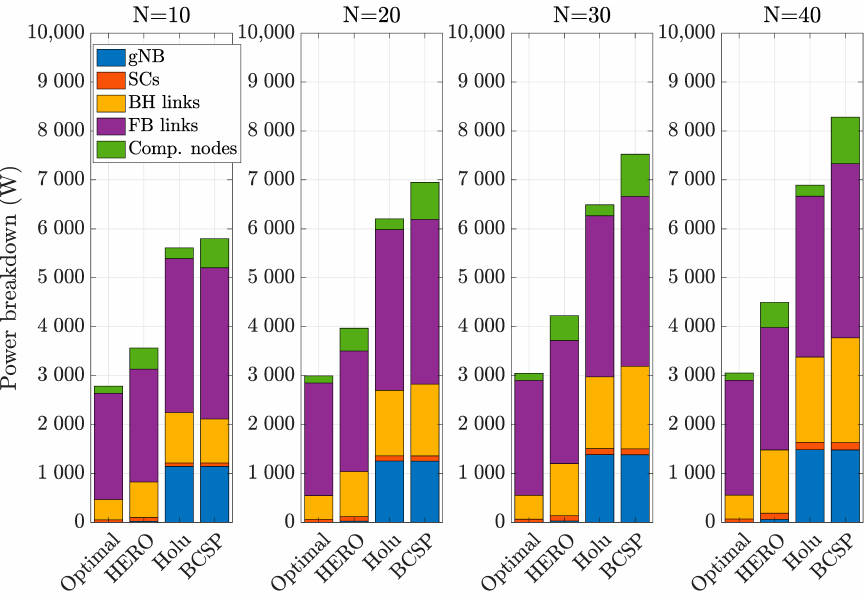
Figure 8. Power (W) breakdown of all algorithms for low traffic ( N = 10) and high traffic ( N =